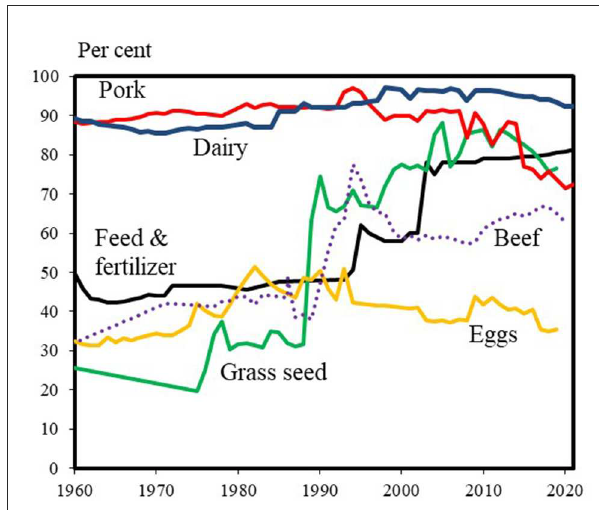
FIGURE2 Domestic market shares for agricultural cooperatives in selected industries. Source: Own calculations based on Danish Agriculture and Food Council (8–10) and annual reports from companies and organizations.